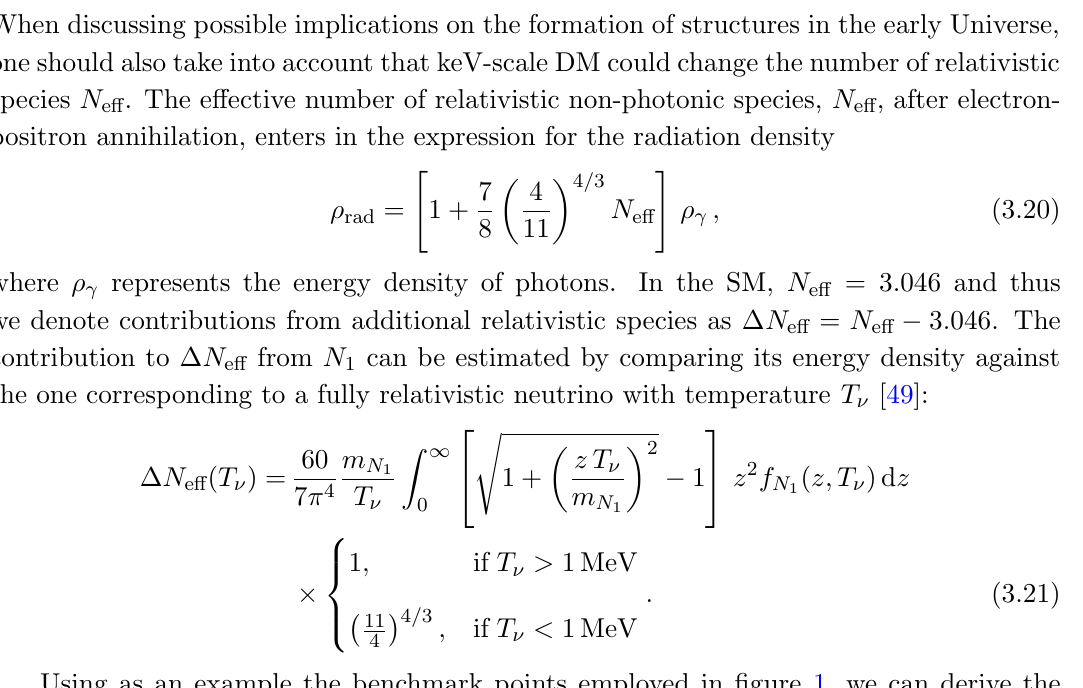
= 400 GeV) is consistent with 2